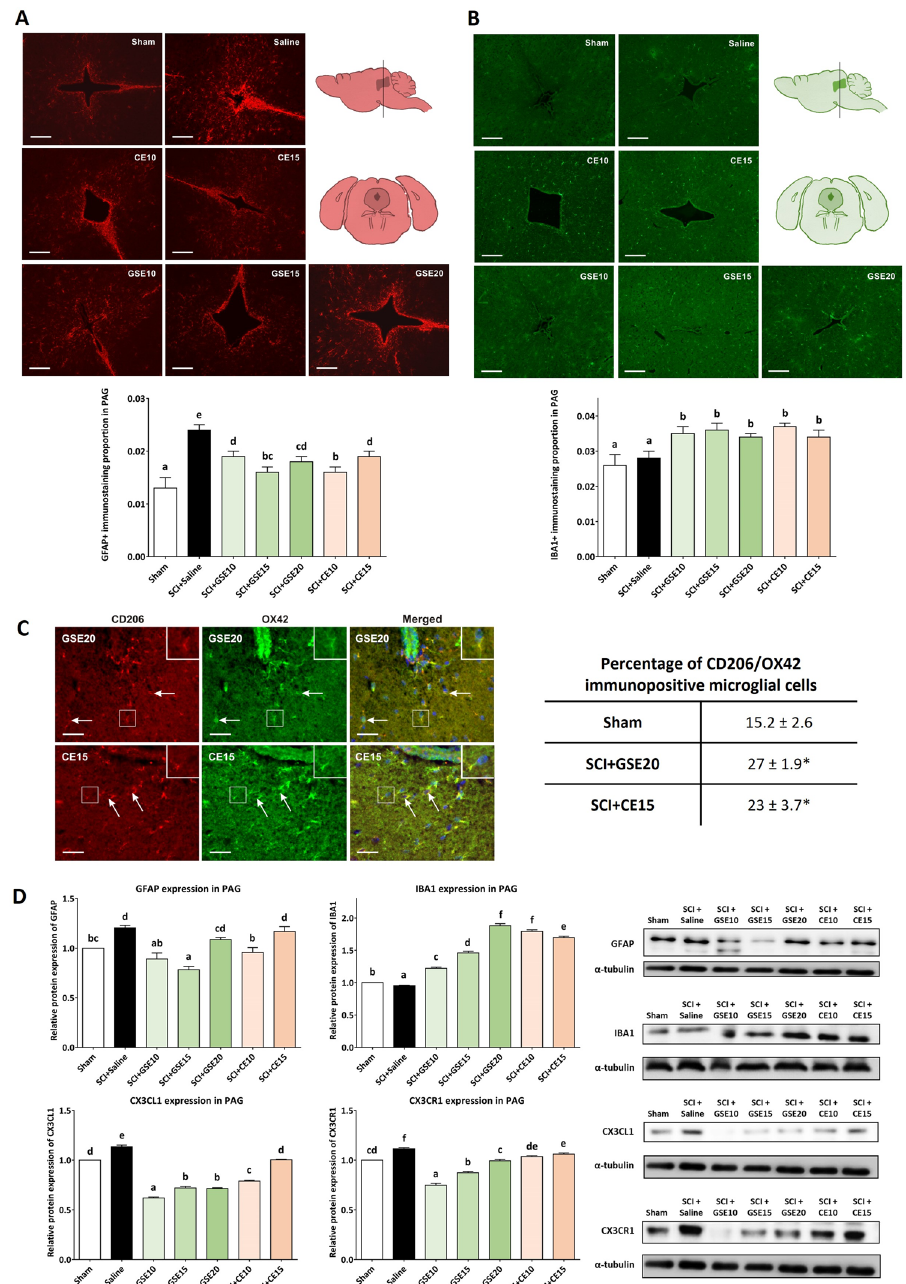
Figure 9. Effects of GSE and CE treatment on gliosis and CX3CL1/CX3R1 expression in the PAG of SCI mice at the end of the experimental period . ( A ) Representative histological images of the PAG immunostained against GFAP of each group (scale bar 200 μm) and histogram representing the proportion of GFAP immunoreactivity in PAG. Data are expressed as the mean ± SEM. ( B ) Representative histological images of the PAG immunostained against IBA1 of each group (scale bar 200 μm) and histogram representing the proportion of IBA1 immunoreactivity in PAG. Data are expressed as the mean ± SEM. ( C ) Percentage of CD206 immunopositive OX42 immunostained microglial cells in PAG of animals with SCI and treated with GSE (20 mg/kg) and CE (15 mg/kg) compared with sham-operated control. * p < 0.01 compared with Sham. Representative pictures illustrating double immunostaining of OX42-immunopositive microglial cells ( A ) and CD206 ( B ) in the PAG sections of mice subjected to SCI and treated with GSE20. Merged green (OX42-FITC) and red (CD206-TRITC) immunofluorescence and blue Hoechst nuclear staining indicate the position of OX42 + /CD206 + microglial cells ( C ). Scale bar = 50 µm. ( D ) GFAP, IBA1, CX3CL1 and CX3CR1 expression in PAG. Protein expression was normalized to a-tubulin. Data are expressed as a relative percentage with respect to the sham group (mean ± SEM). Control images were reused either for illustrative purposes or methodological purposes when several protein levels were assessed in one blot. Full-length blots are presented in Supplementary Fig. S7. a–g: Groups not sharing a letter showed significant differences, p < 0.05. Experimental groups: Sham (GFAP n = 5; IBA1 n = 5; CX3CL1 n = 6; CX3CR1 n = 6), SCI + saline (GFAP n =